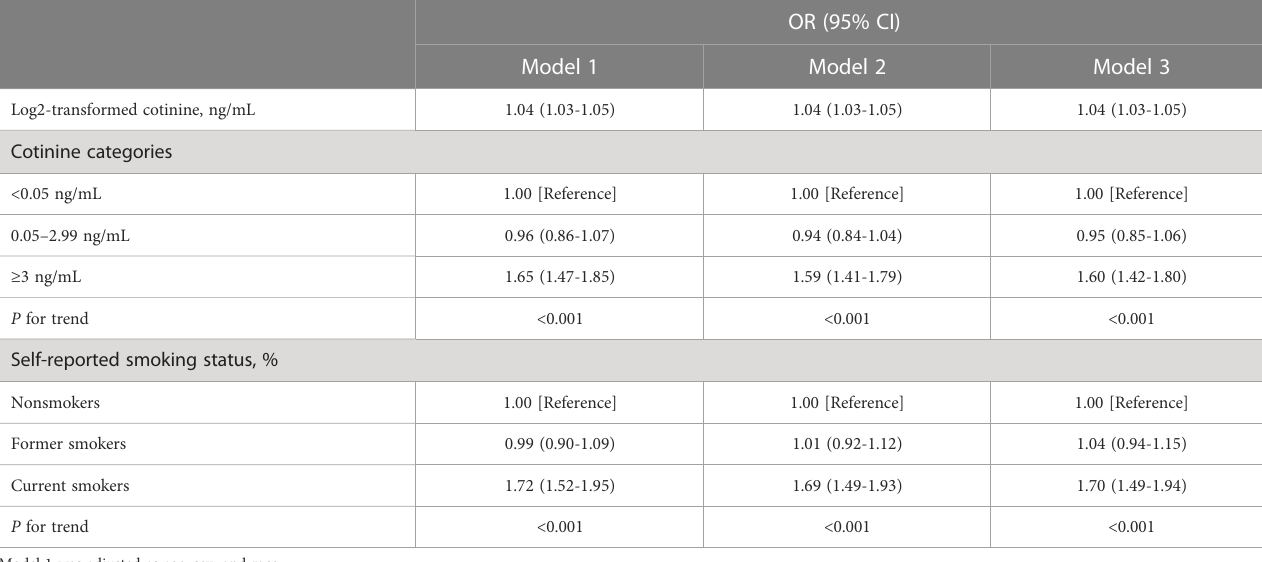
TABLE 4 Association of smoking status, serum cotinine level and the prevalence of